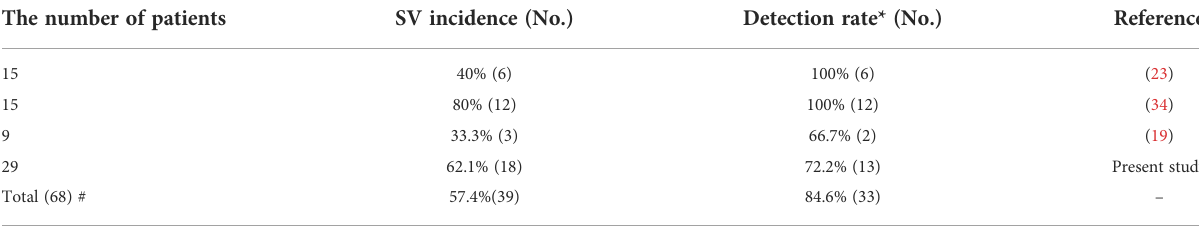
TABLE 4 The summary of incidence of SV phenotype and promoter variants in 21-OHD patients harboring P31L. The number of